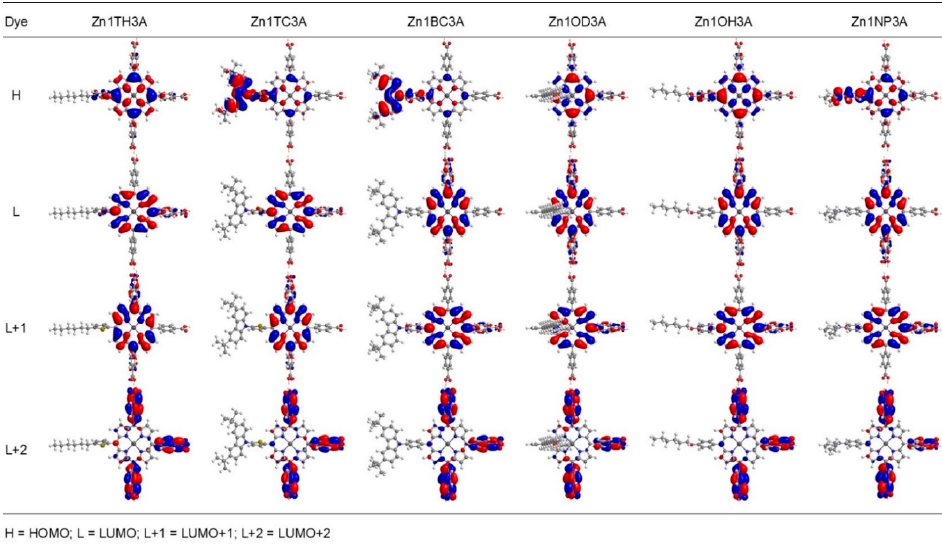
Figure 4. Molecular orbital diagrams of 1D- π -3A porphyrins obtained from density functional theory (DFT) calculations.